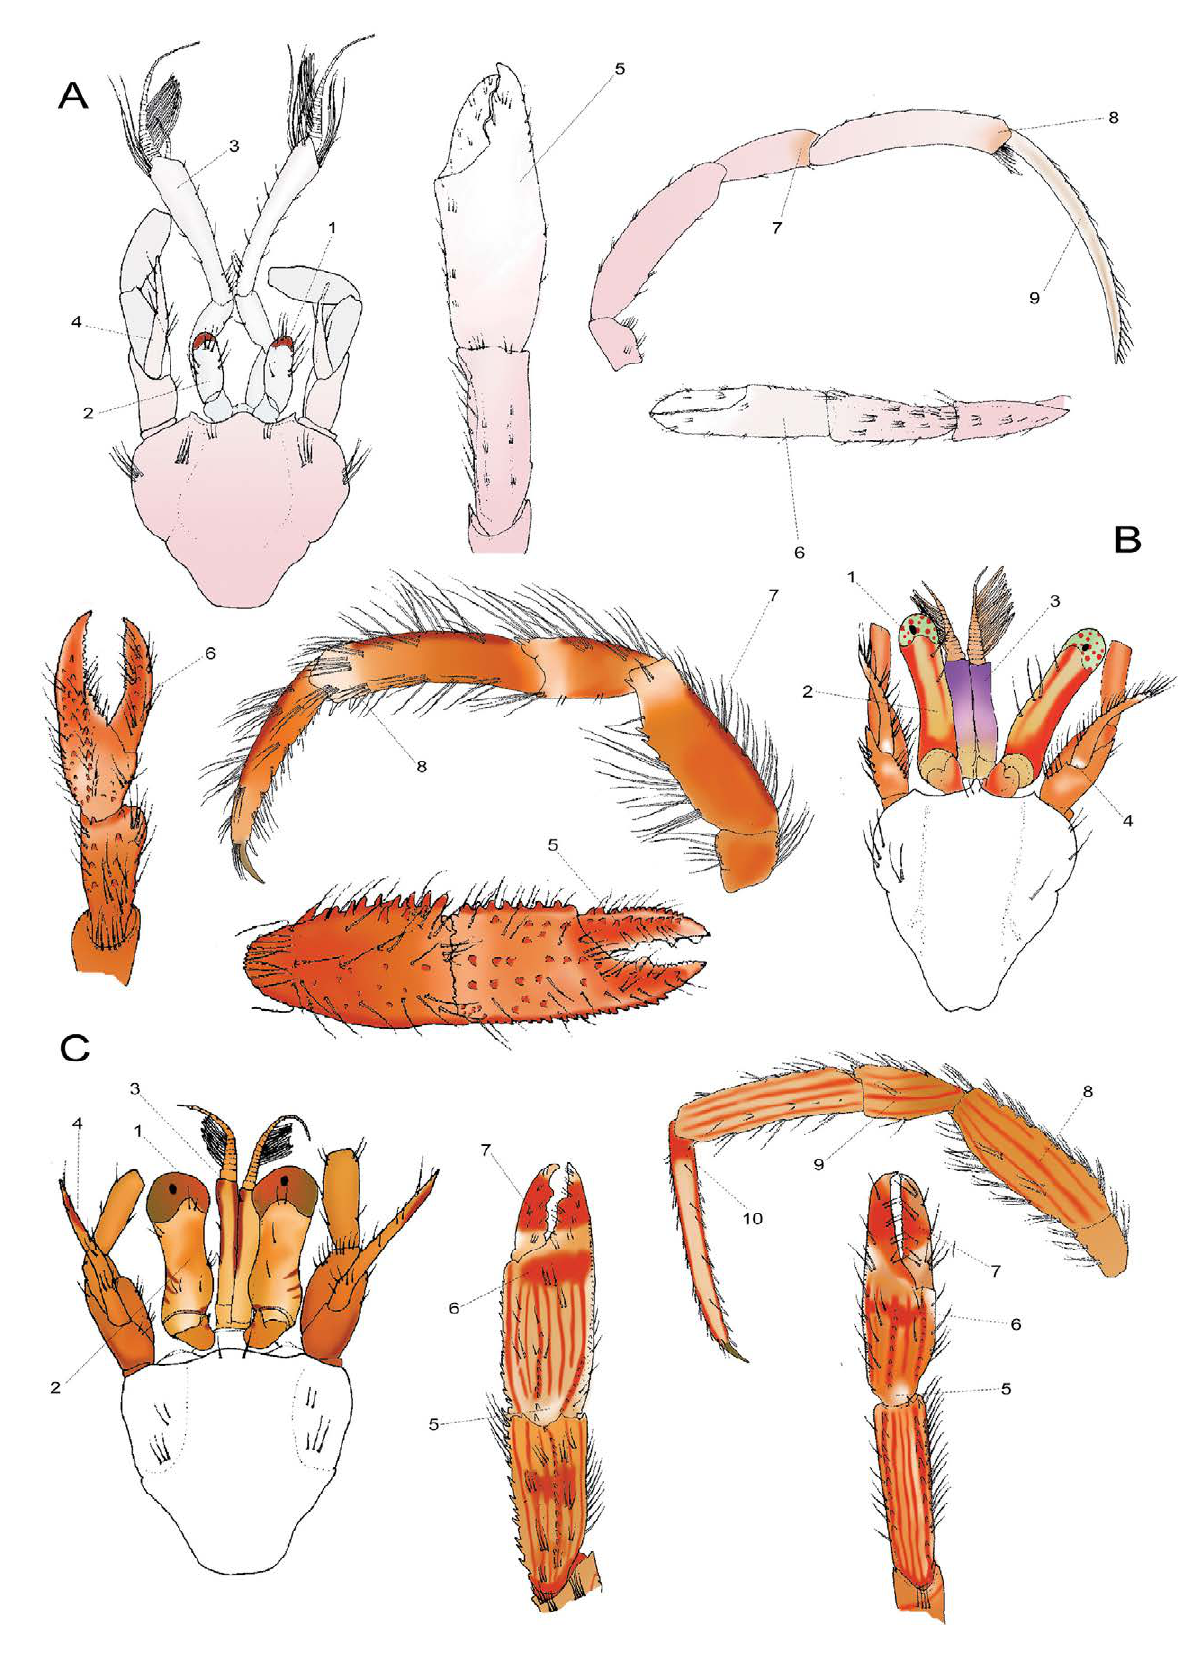
Fig. 7. – Colour patterns of Paguridae species: Catapaguroides microps (A, 1-9); Cestopagurus timidus (B, 1-8); Nematopagurus longicornis (C, 1-10). All vectorial drawings modified from Ingle